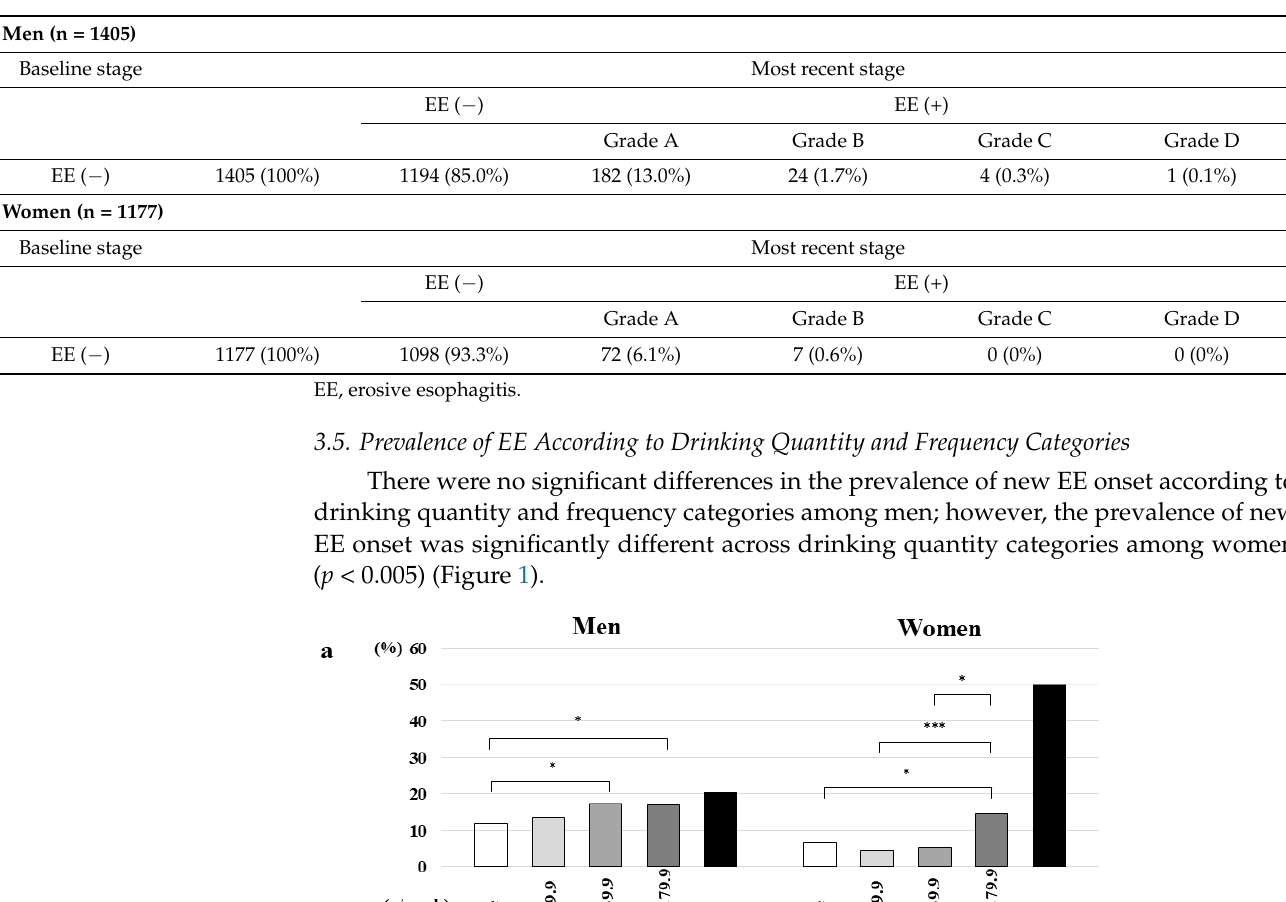
Table 4. Presence or absence of EE at the final measurement in patients without EE at baseline.